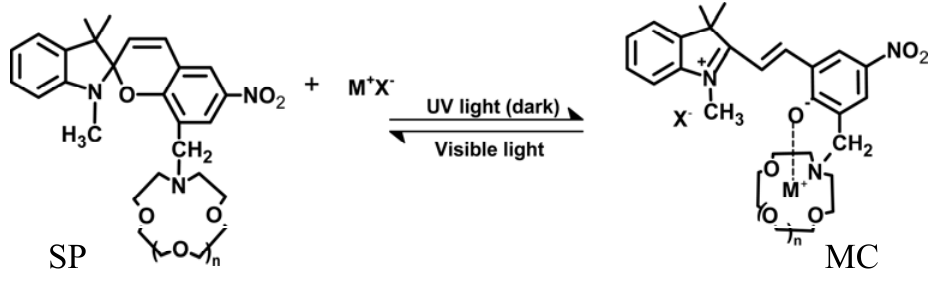
Figure 19. Photo-isomerization of crowned